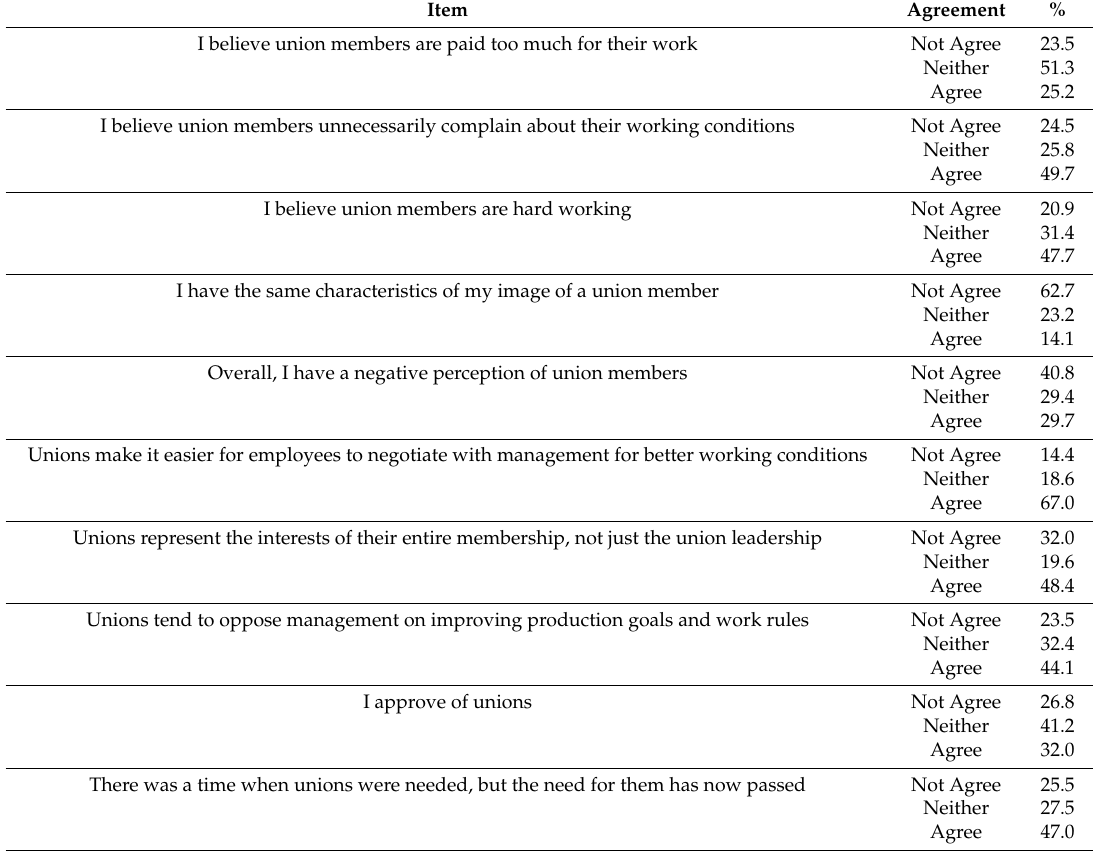
Table 3. Similarity to prototype, negative perception of union member and intentions to join